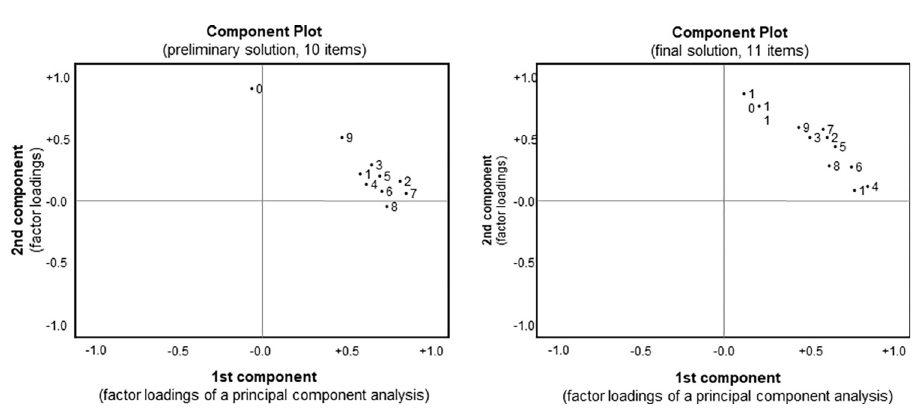
Fig 1. Factor analyses to identify the items of the scale on active individual knowledge transfer. left: preliminary solution, right: final solution; numbers refer to item numbers in Table 3.